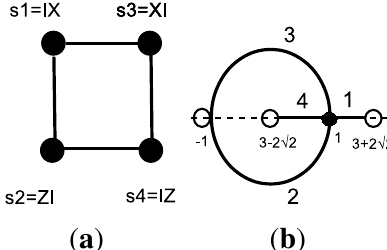
Figure 2. ( a ) The square graph of Bell’s theorem; ( b ) the dessin stabilizing the square